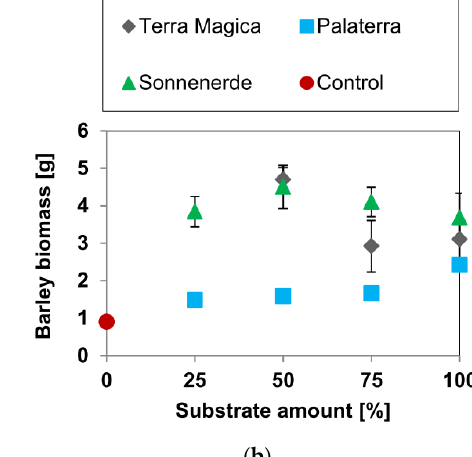
( b ) Figure 2. Wheat yield per pot after 30 days in peat-based ( a ) and biochar-based ( b ) growing media mixed with sand in different amounts. In this Figure, 0% = control (pure sand) and 100% = pure